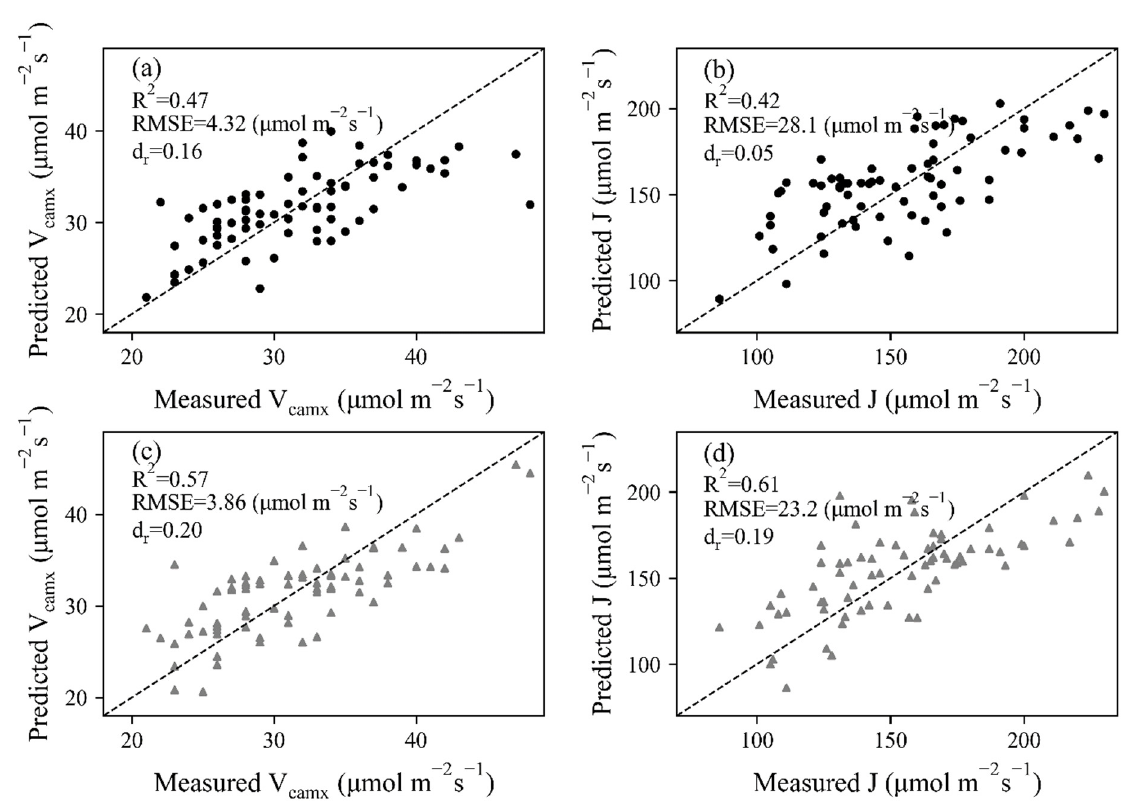
Figure 6. Leave-one-out cross-validation results of V cmax and J for ( a , b ) HSL and ( c , d ) ASD dataset. The dashed lines stand for 1:1 lines. for 1:1